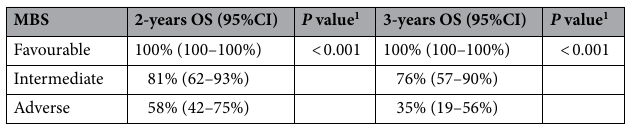
Table 5. Bootstrap (R = 1000) for 2-years and 3-years OS. 1 Kruskal-Wallis Test.